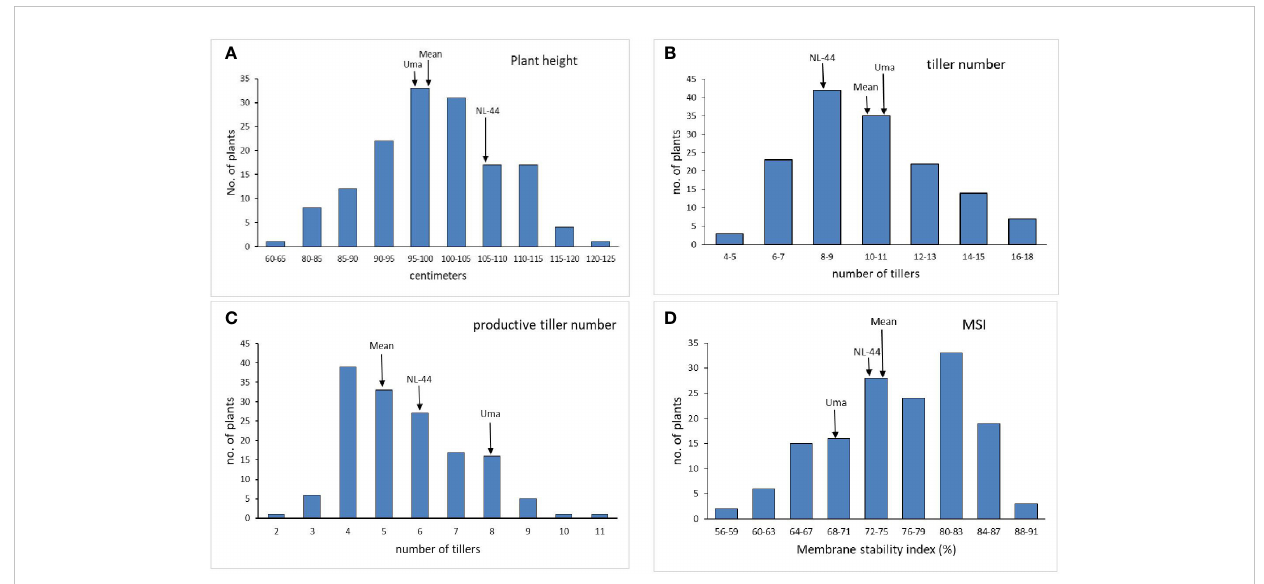
FIGURE 1 Frequency distribution of plant height (A) , tiller number (B) , productive tiller number (C) , and membrane stability index (MSI) (D) under the effect of high temperature stress among the F 2